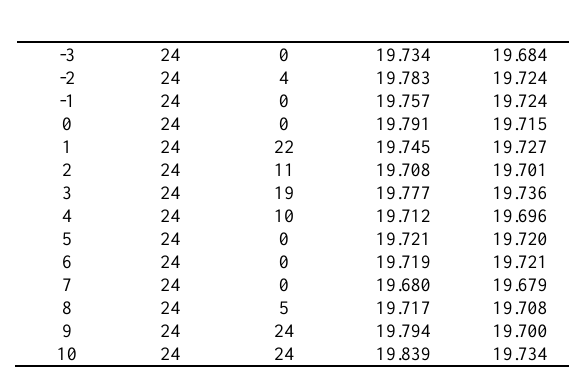
Table 19. Results under Scenario 2c (Node 3 and Node 17).